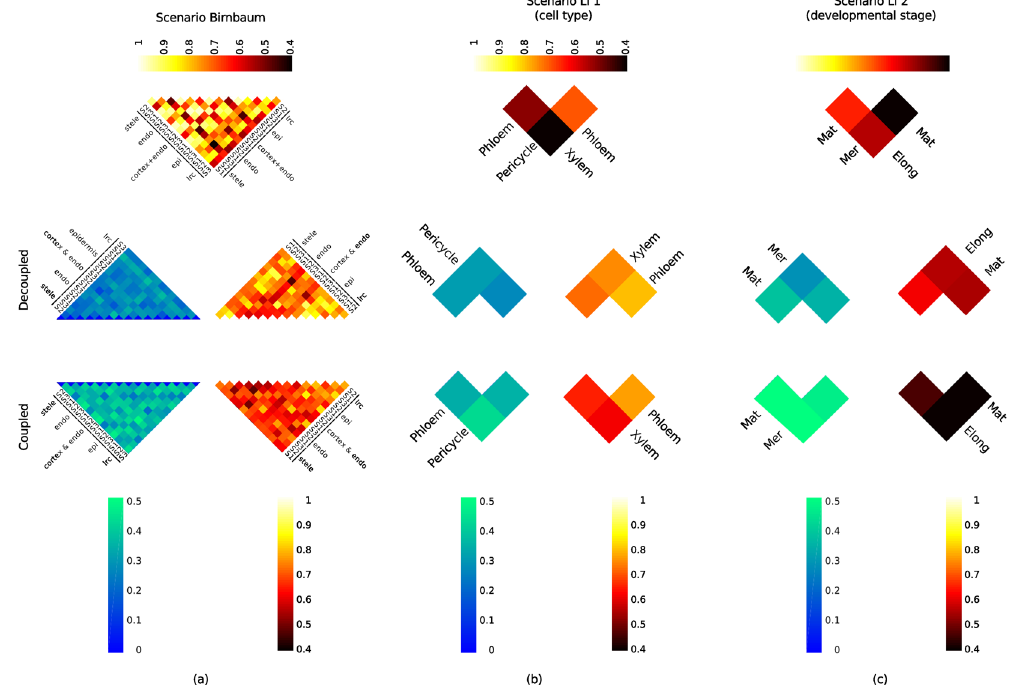
Figure 4. Structural and functional comparison of extracted models. For three scenarios the decoupled models were compared with coupled models: ( a ) scenario Birnbaum (only transcriptomics data from Birnbaum et al . are used) ( b ) scenario Li 1 in which transcriptomics data for different cell types from Li et al . were considered and ( c ) scenario Li 2 in which the gene expression data for three developmental stages were considered. The heat maps on the left side correspond to the Jaccard distances, while those on the right side refer to the Pearson correlation of the flux